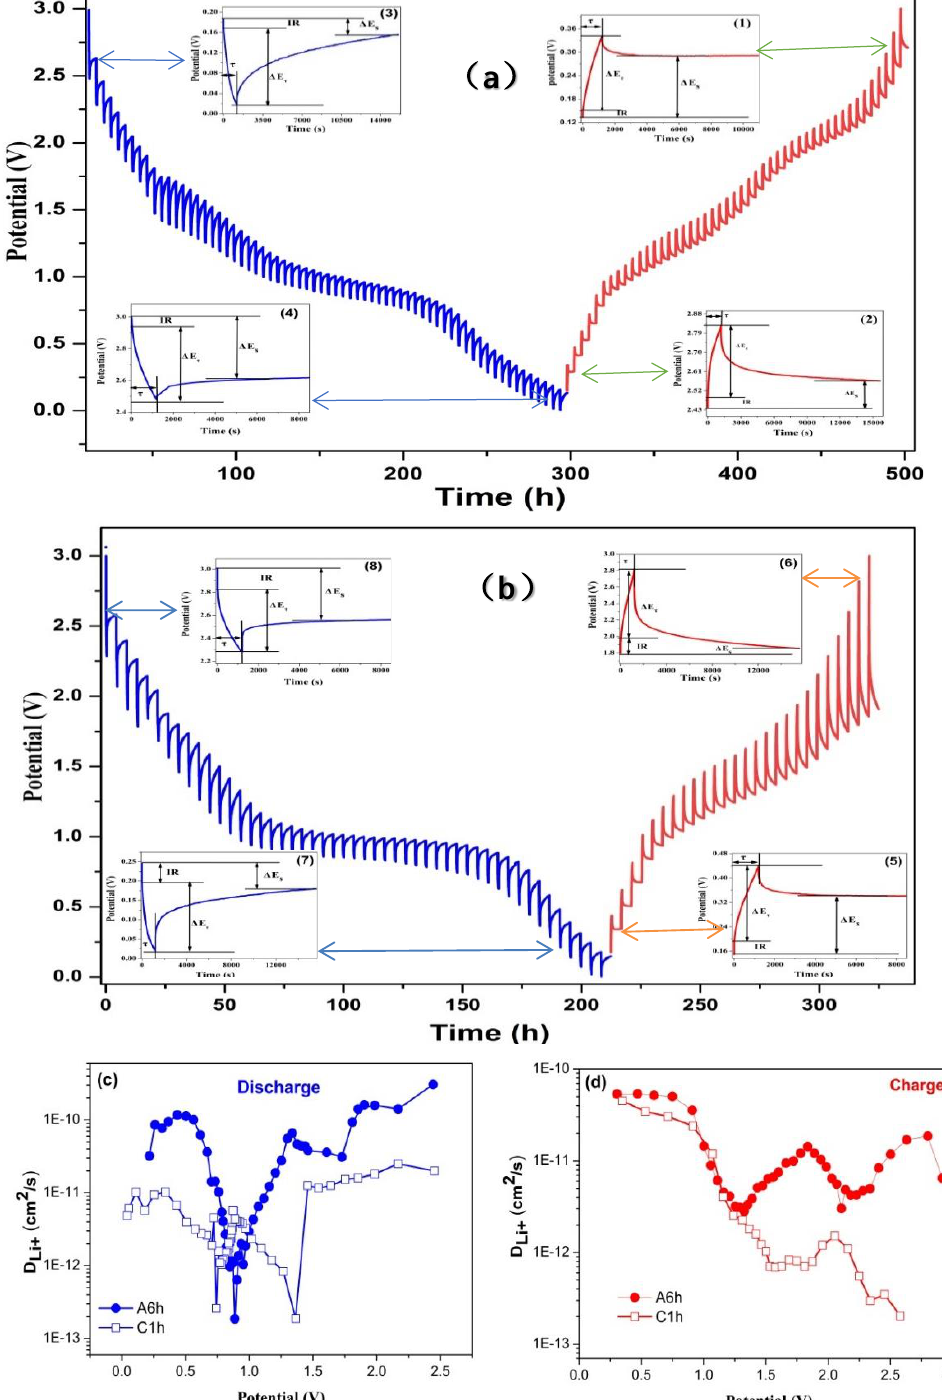
Figure 7. GITT profiles of the amorphous and crystalline Fe 2 O 3 electrodes: ( a ) A6h and ( b ) C1h. The insets show polarized curves for current pulse steps derived from the GITT data at different potentials in the discharge and charge processes. ( c , d ) Li + diffusion coefficients of the electrodes during the discharge/charge process at various voltages derived from the GITT data: ( a ) A6h and ( b ) C1h.